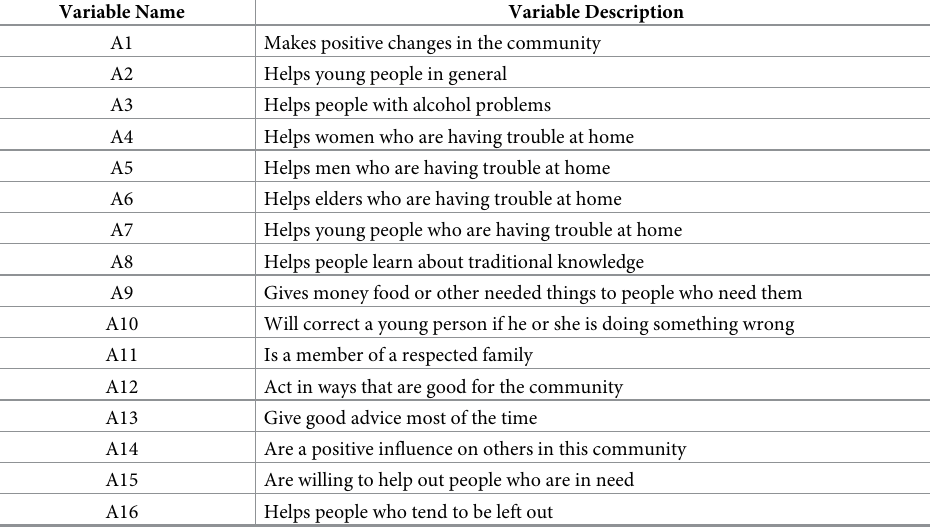
Table 1. Attribute